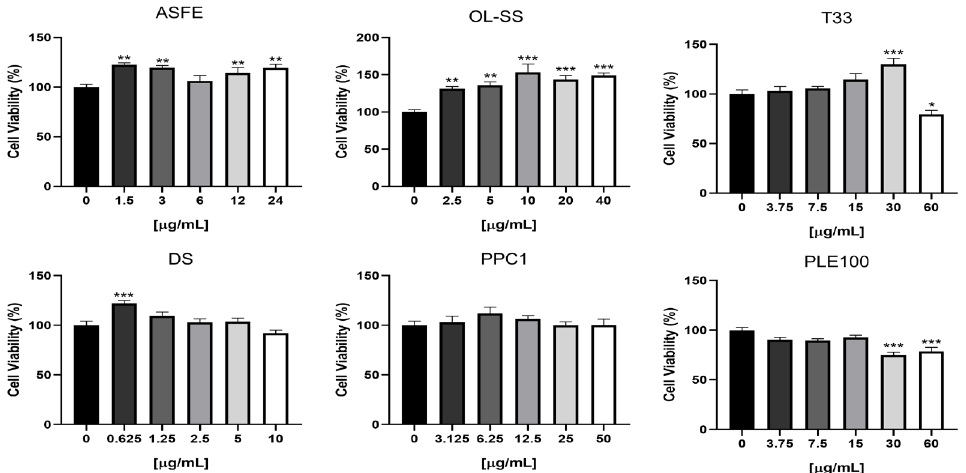
Figure 2 . HBMEC viability upon exposure to the extracts at different concentrations. HBMEC cells were treated with the indicated concentrations of each extract: cooperage woods of Robinia pseudoacacia (ASFE), Olea europaea L. leaves (OL-SS), Cyphomandra betacea peel (T33), Dunaliella salina (DS), Coffea arabica silverskin (PPC1), and Citrus sinensis waste (PLE100), diluted in RPMI, or RPMI only (control), for 4 h. Cell viability was assessed by the MTT assay, and the values are presented as a percentage relative to untreated cells (control). All values are given as mean ± SEM of three independent experiments performed in triplicate. Statistical analysis was performed by one-way ANOVA. Significance is shown as * p < 0.05, ** p < 0.01 and *** p < 0.001 vs. control.